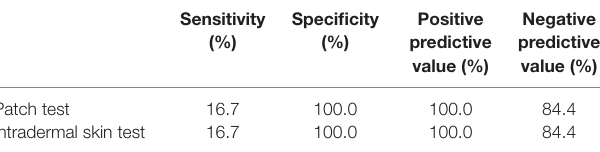
TaBle 6 | sensitivity, specificity, positive and negative predictive value of patch testing and intradermal testing for aeD